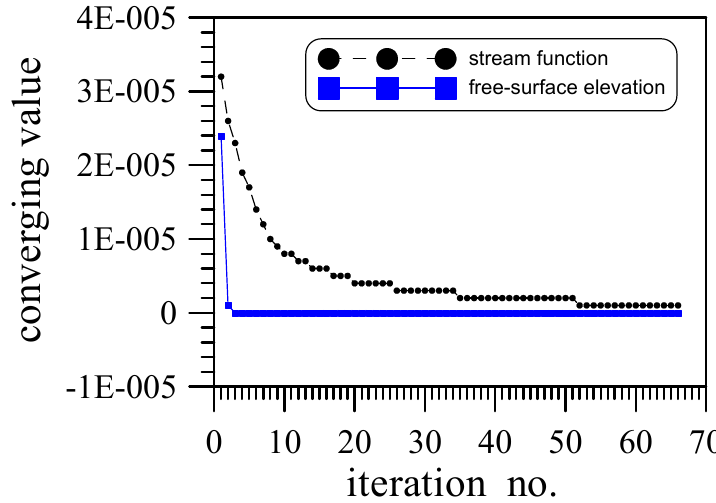
Figure 3. Diagram of the flow over a depression.